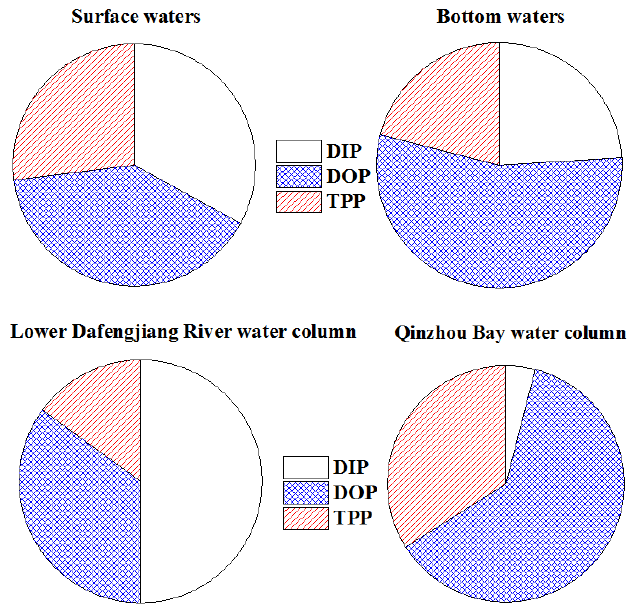
Figure 7. The partitioning of P among DIP, DOP, and TPP in surface waters, bottom waters, lower Dangfengjiang River water column, and Qinzhou Bay water column.